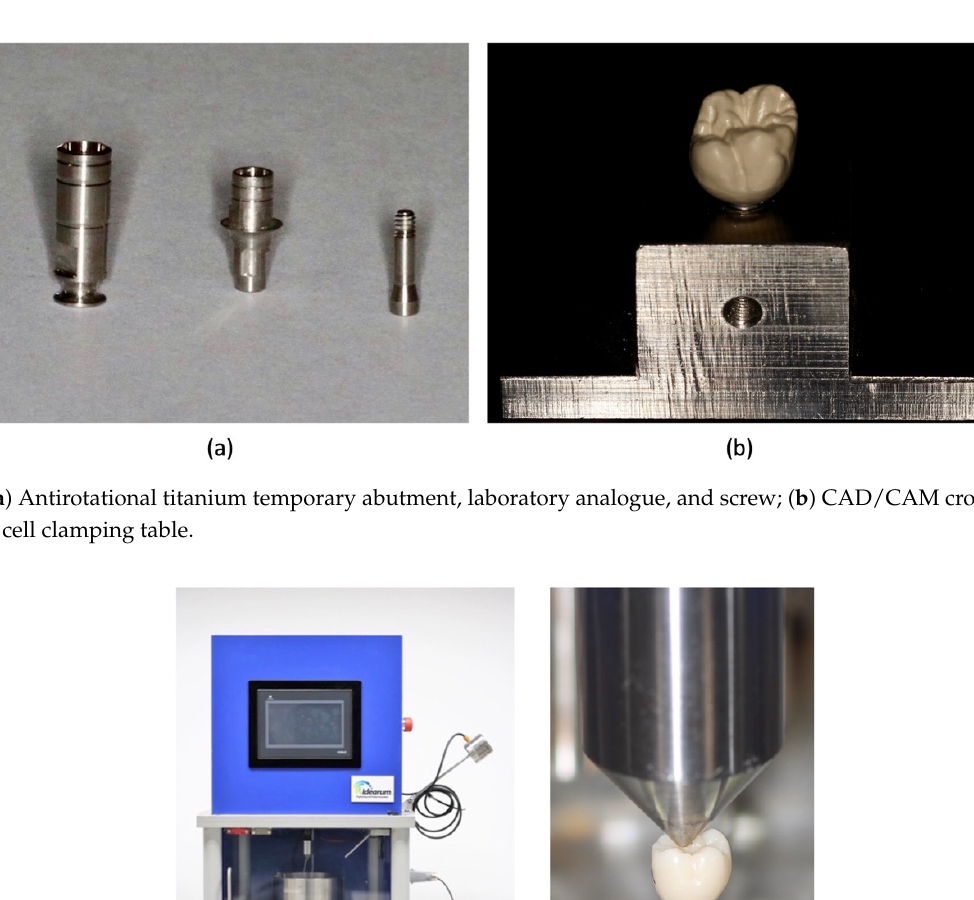
Figure 1. Temporary crowns in CAD/CAM: ( a ) PMMA (Temp Basic ® ), ( b ) composite resin (Lava Ultimate ® ), and ( c ) PEEK (Tecno Med Mineral ® ).